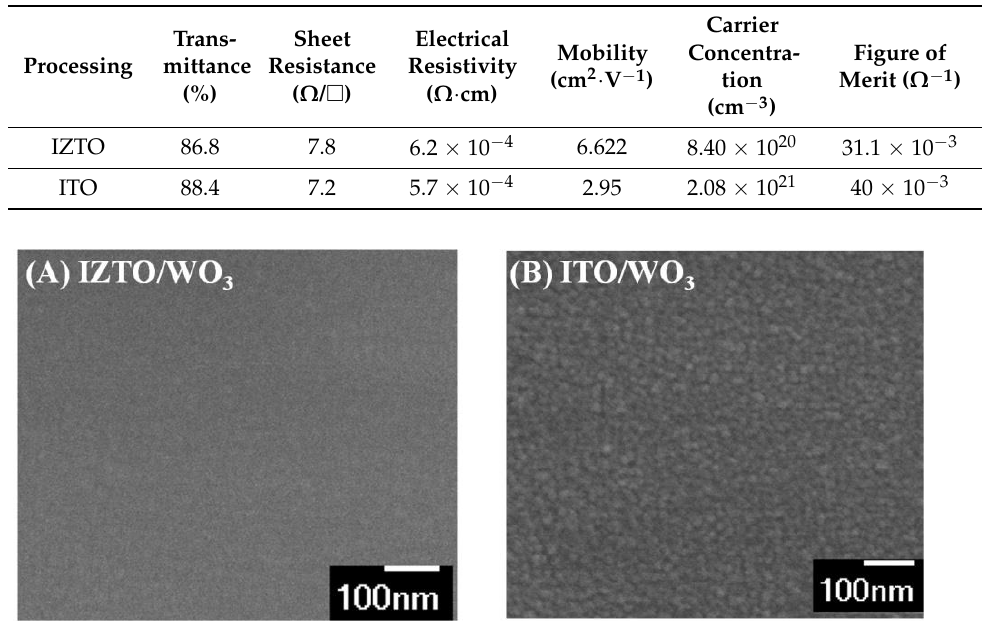
Figure 4. (A) SEM images of WO 3 /IZTO/glass and ( B ) SEM images of WO 3 /ITO films.